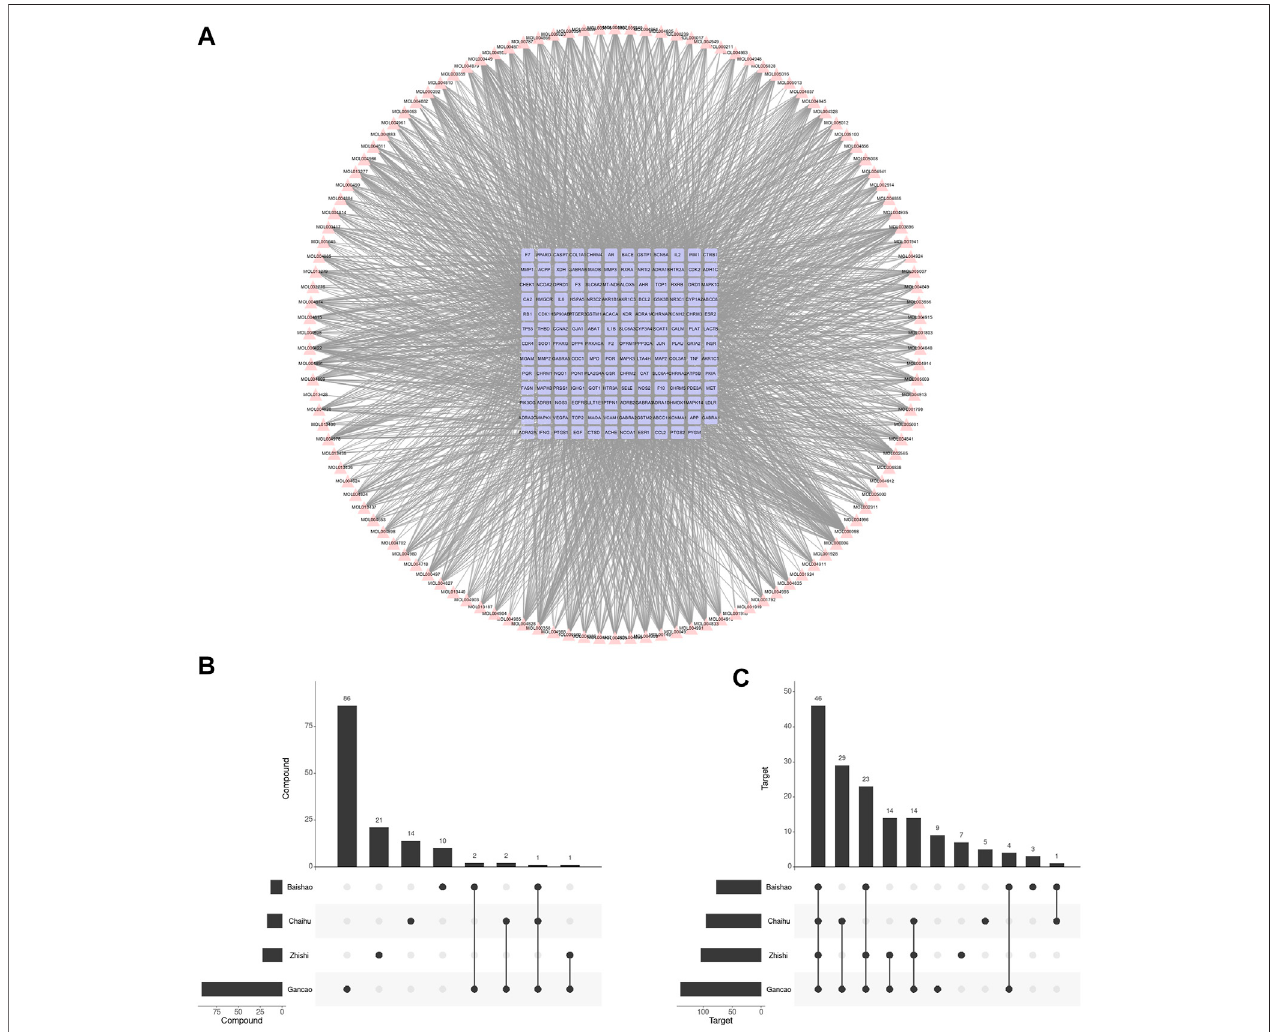
FIGURE 2 | Compounds in SNS and their corresponding targets. (A) Compound-target network of SNS. (B) The SNS compound amount in each botanical drug. (C) The SNS target amount in each botanical drug.